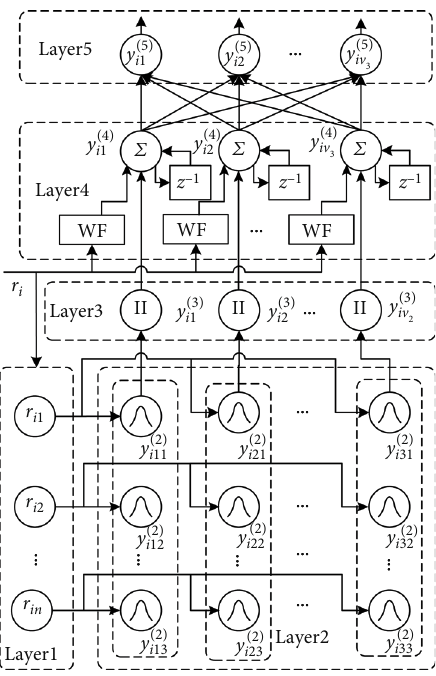
Figure 1: The structure of the RWFNN for each